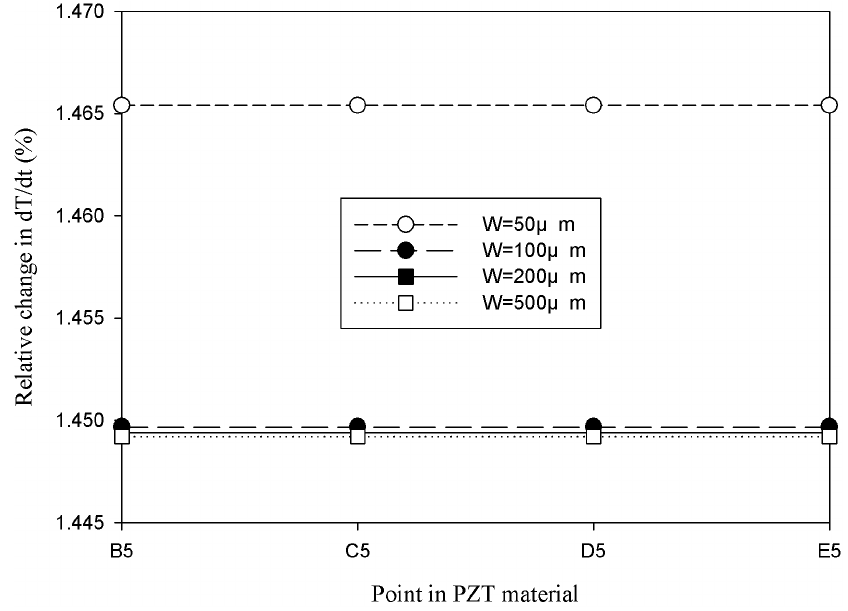
Figure 11. Simulated relative change in the maximum peak value of the temperature variation rate at points B5, C5, D5 and E5 for the mesh top electrode, as compared to that at point A5 for the fully covered electrode with various electrode